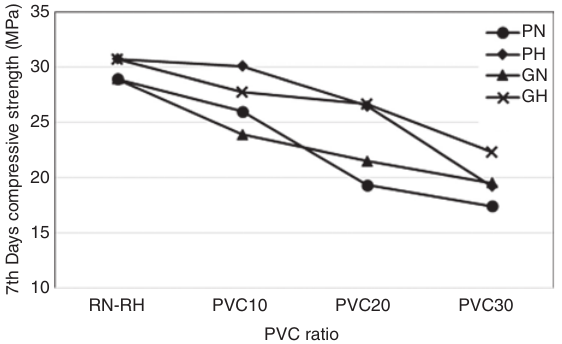
Figure 11 Seventh day compressive